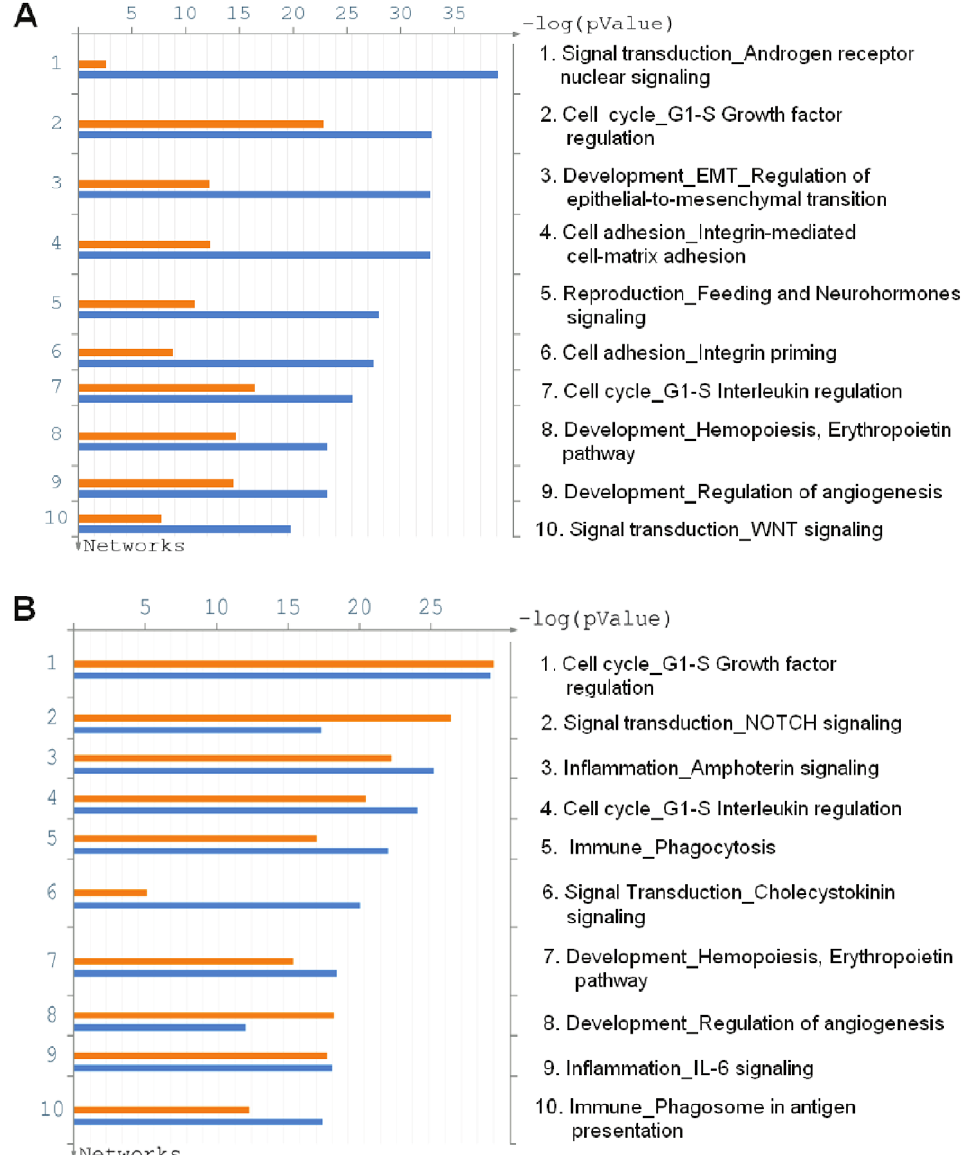
Figure 1. Functional analysis of topologically significant proteins. (A) Enrichment of GeneGo process networks by topologically significant proteins identified using all up-regulated genes and proteins. (B) Enrichment of GeneGo process networks by topologically significant proteins identified using truncated sets of data (excluding genes and proteins directly regulated by androgen receptor). Orange bars– enrichment by significant proteins identified using proteomics data set. Blue bars–enrichment by significant proteins identified using gene expression data.